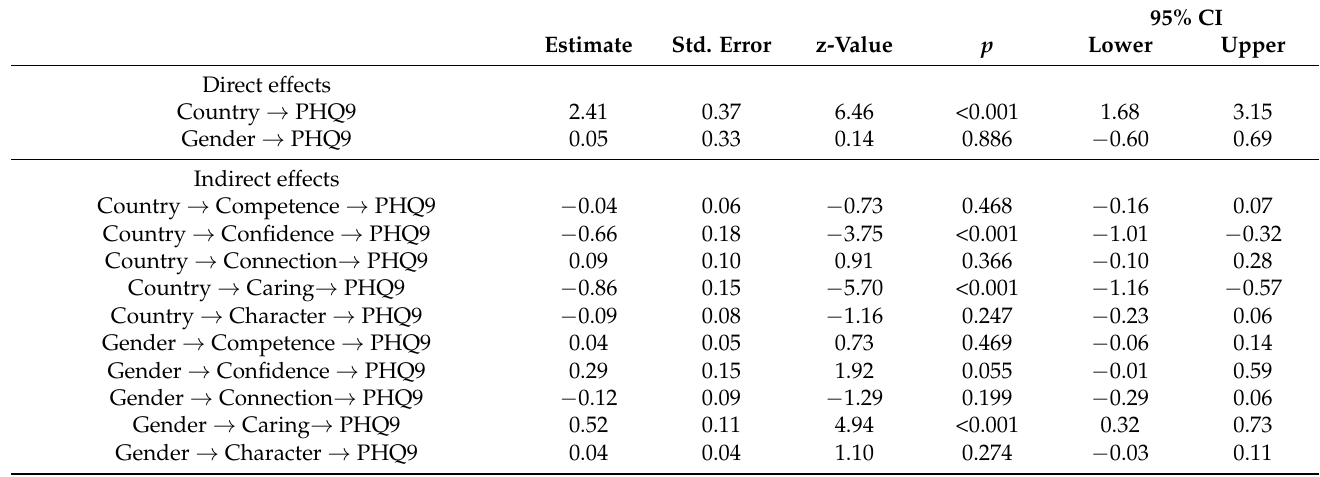
Table 6. Multiple partial mediation model of the effects of gender and country on depressive symptoms through the 5Cs of PYD, direct, indirect, total effects, and residual covariances.